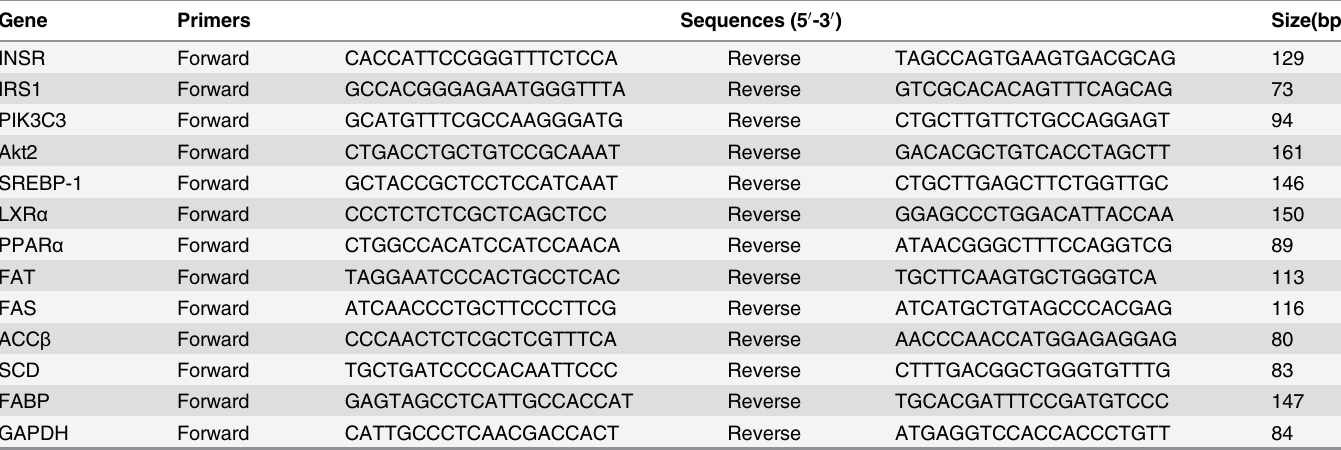
Table 2. Primer sequences used for quantitative real-time PCR assays.